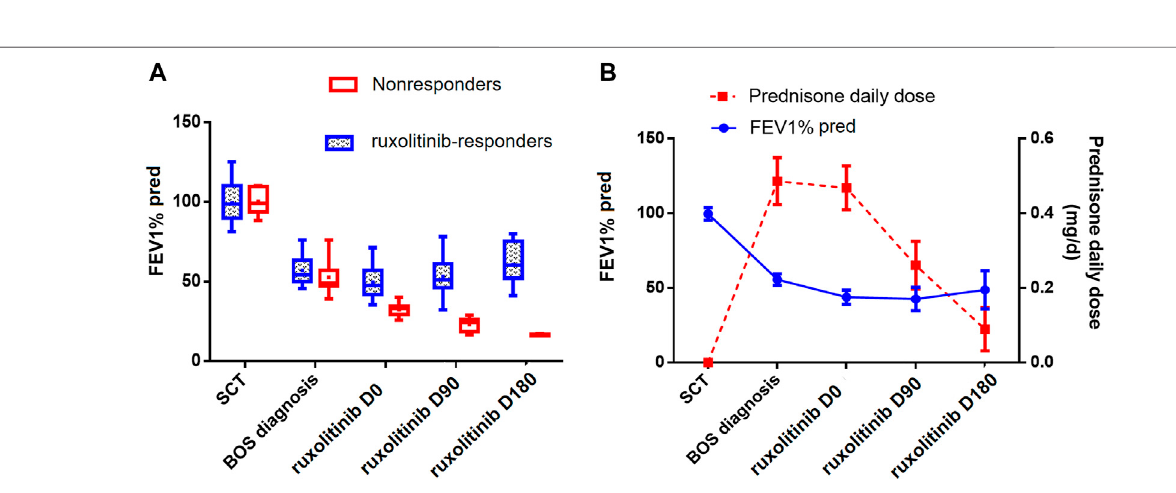
FIGURE 3 | (A) Distribution of FEV1%pred over time in ruxolitinib responders and nonresponders. (B) Distribution of FEV1% pred and prednisone daily dose over time in all ruxolitinib-treated patients. All the parameters were represented by the mean values and 95%CI. FEV1%pred, forced expiratory volume in 1 s of predicted; BOS, bronchiolitis obliterans syndrome; SCT, stem cell transplantation.